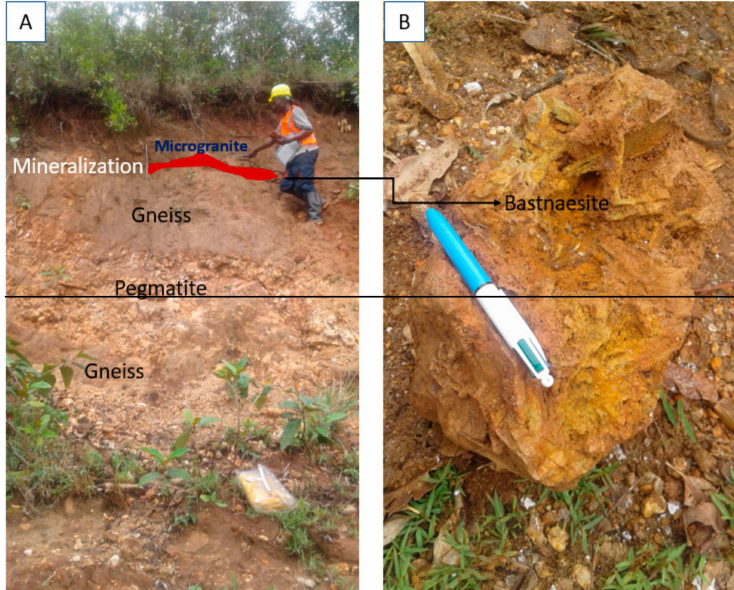
Figure 9. ( A ) Masenga outcrop exposing the foliated orthogneiss, cut by a foliated low-dipping pegmatite and by an isotropic 20-cm wide low-dipping microgranite dyke (close to the worker). ( B ) Large bastnaesite crystals presently altered into a monazite-rich greenish product. Empty spaces between crystals are